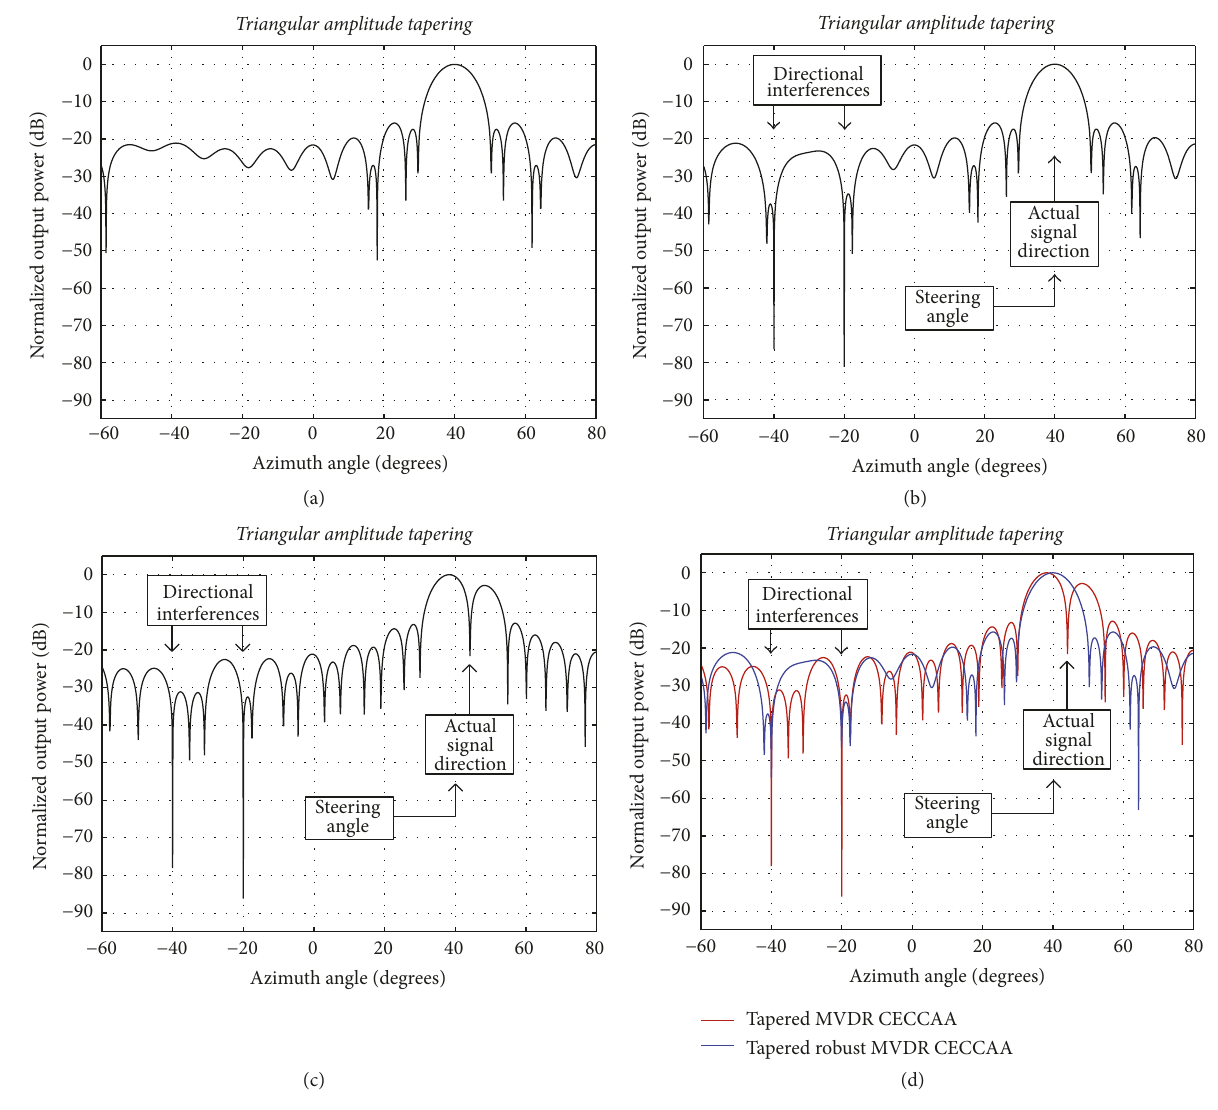
Figure 7: (a) Normalized power pattern of Triangular tapered CECCAA. (b) Normalized power pattern of Triangular tapered MVDR CECCAA without presence of array imperfections. (c) Normalized power pattern of Triangular tapered MVDR CECCAA in the presence of array imperfections. (d) Normalized power pattern comparison of the Triangular tapered MVDR CECCAA and proposed Triangular tapered robust MVDR CECCAA in the presence of array